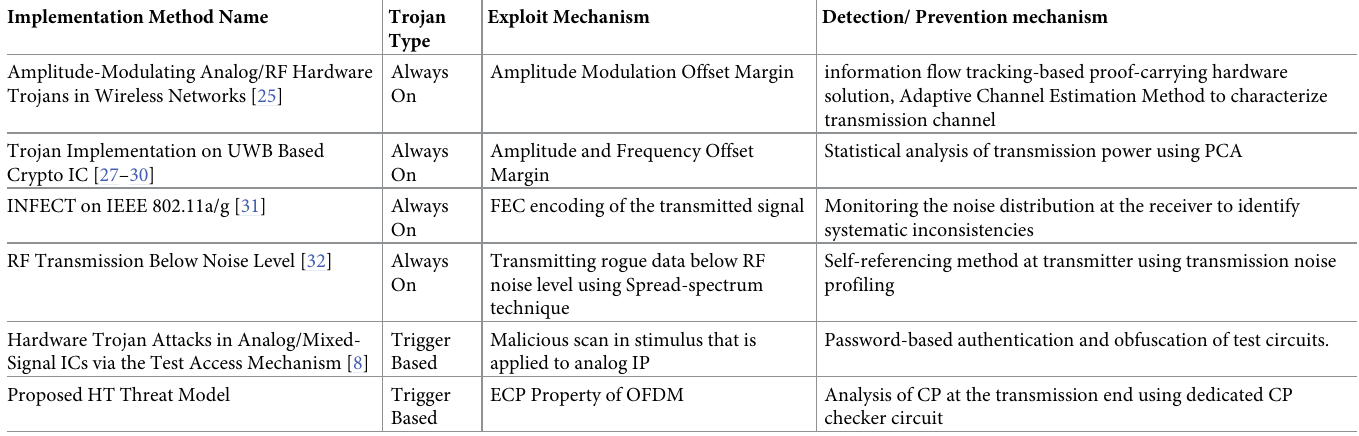
Table 2. Comparison between proposed HT threat model and existing HT threat